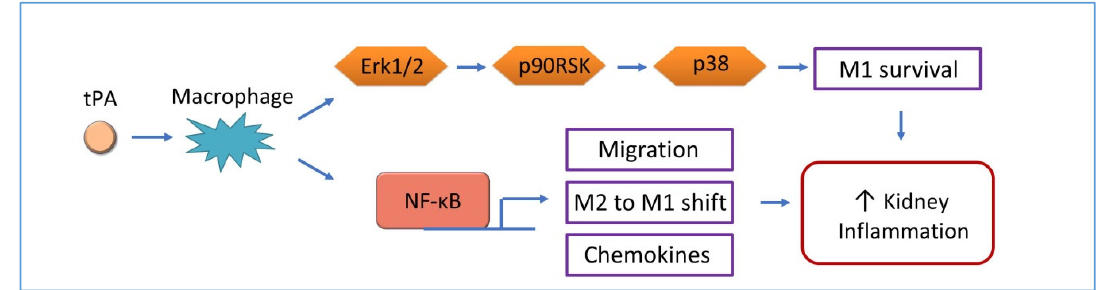
Figure2. tPAsignalinginkidneydisease. tPApromoteskidneyinflammationthroughNF- κ B-dependent Figure 2. tPA signaling in kidney disease. tPA promotes kidney inflammation through NF- κ B- or independent dependent or independent pathways.